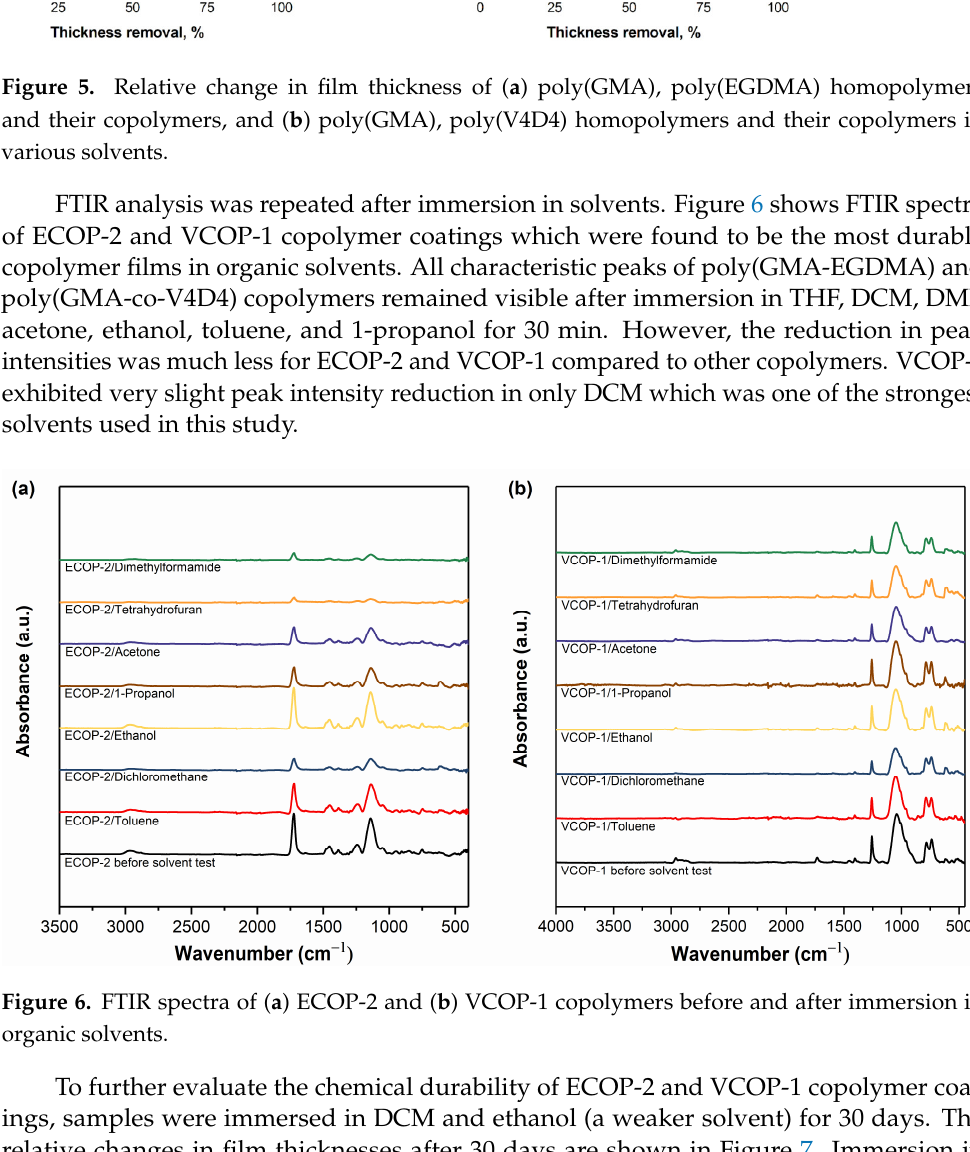
Figure 7. Relative change in film thickness for copolymers after immersion in DCM and ethanol.